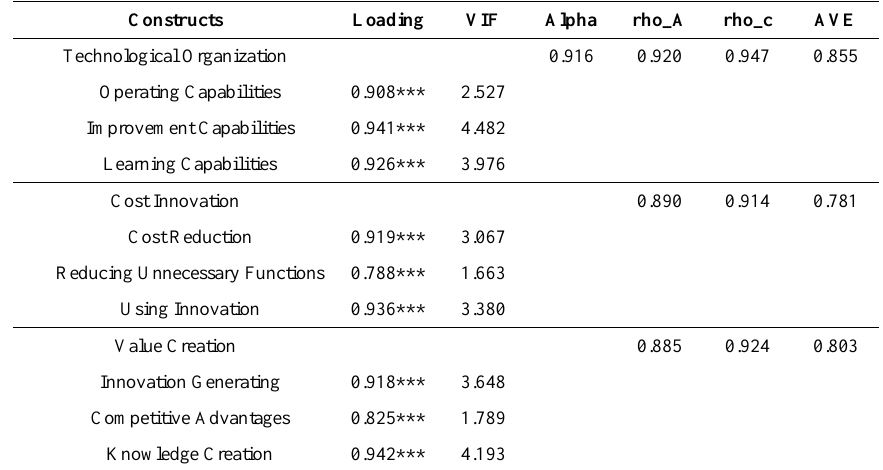
Table 3. Factor Loading, Collinearity (VIF), Internal Consistency Reliability, and Convergent Validity